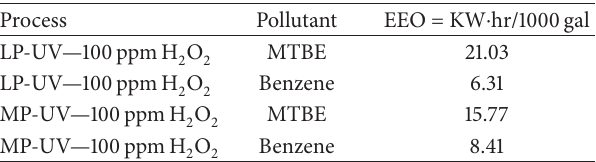
Figure 8: By-products formed due to degradation of MTBE. Table 2: The EEO values for MTBEand benzene by LP-UV and MP- O UV at 100ppm of H 2 2